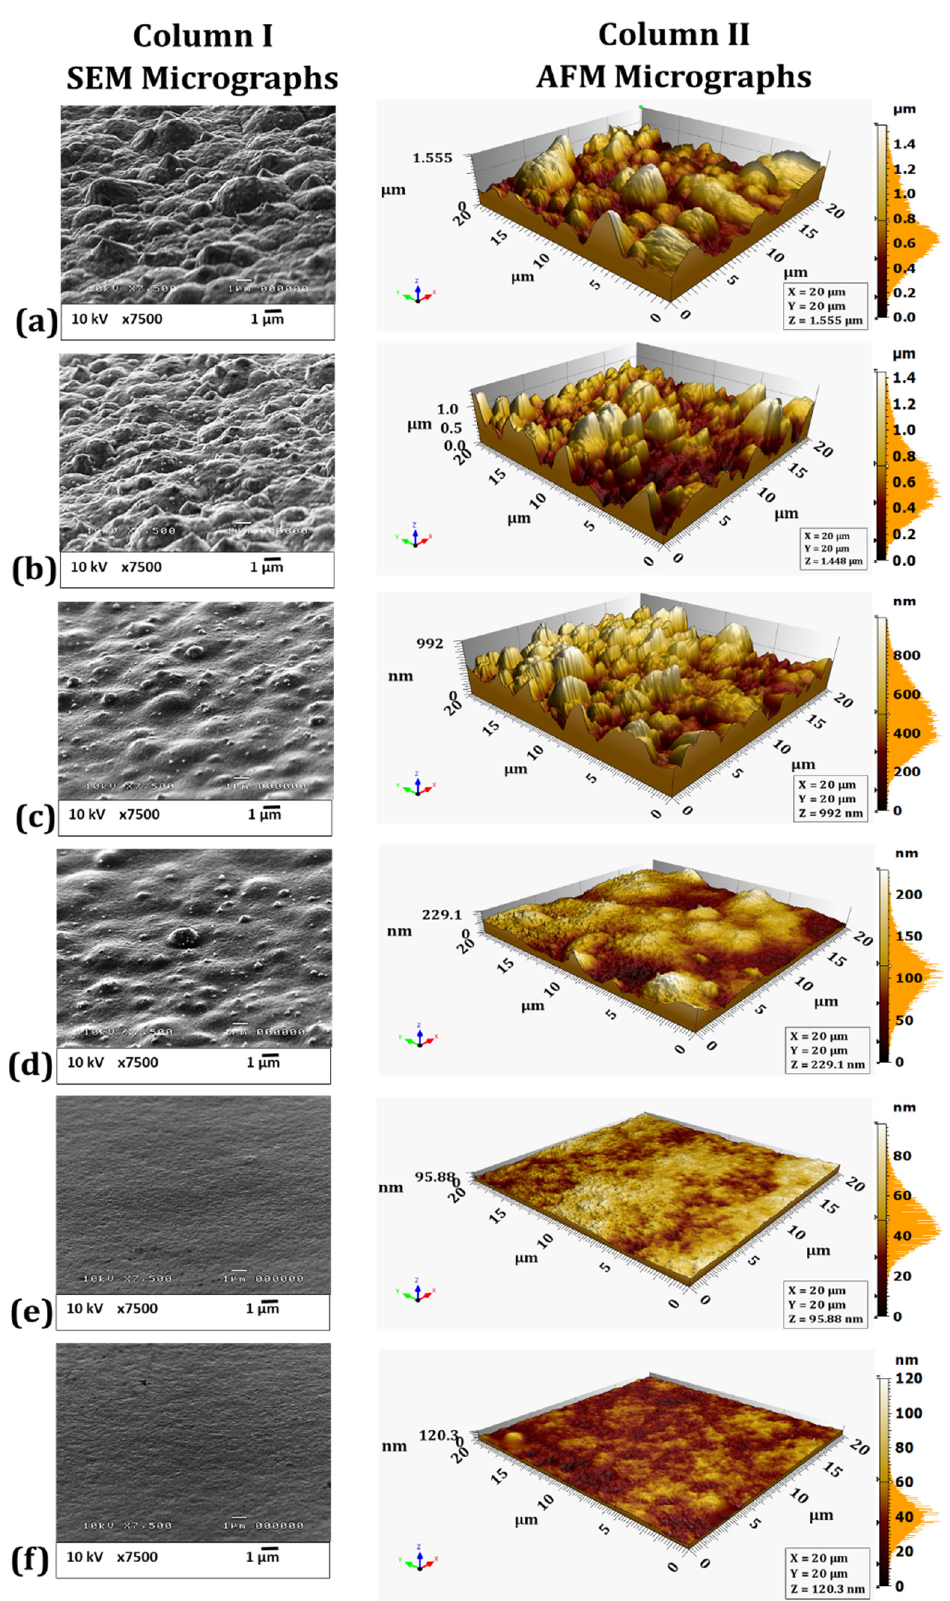
Figure 6. SEM micrographs with a magnification of 7500 (Column I) and AFM micrographs with a scan area of 20 µm × 20 µm (Column II) of eNiCo alloy coating samples electrodeposited at 50 mA/cm 2 , pH 4, 45 °C, 15 min with cathode at x = 40 mm from vortex core at different BHD by varying flow velocities v , ( a ) 0 cm/s; ( b ) 8.8 cm/s; ( c ) 18 cm/s; ( d ) 26 cm/s; ( e ) 34 cm/s; and ( f ) 42 cm/s.